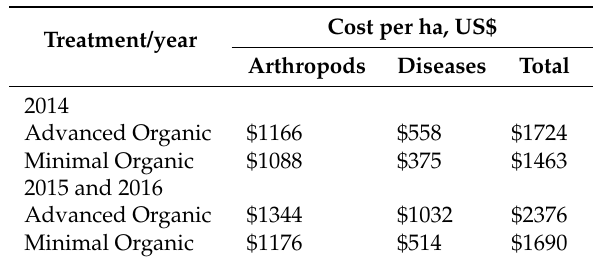
Table 8. Costs of arthropod and disease control products sprayed under different organic management programs,